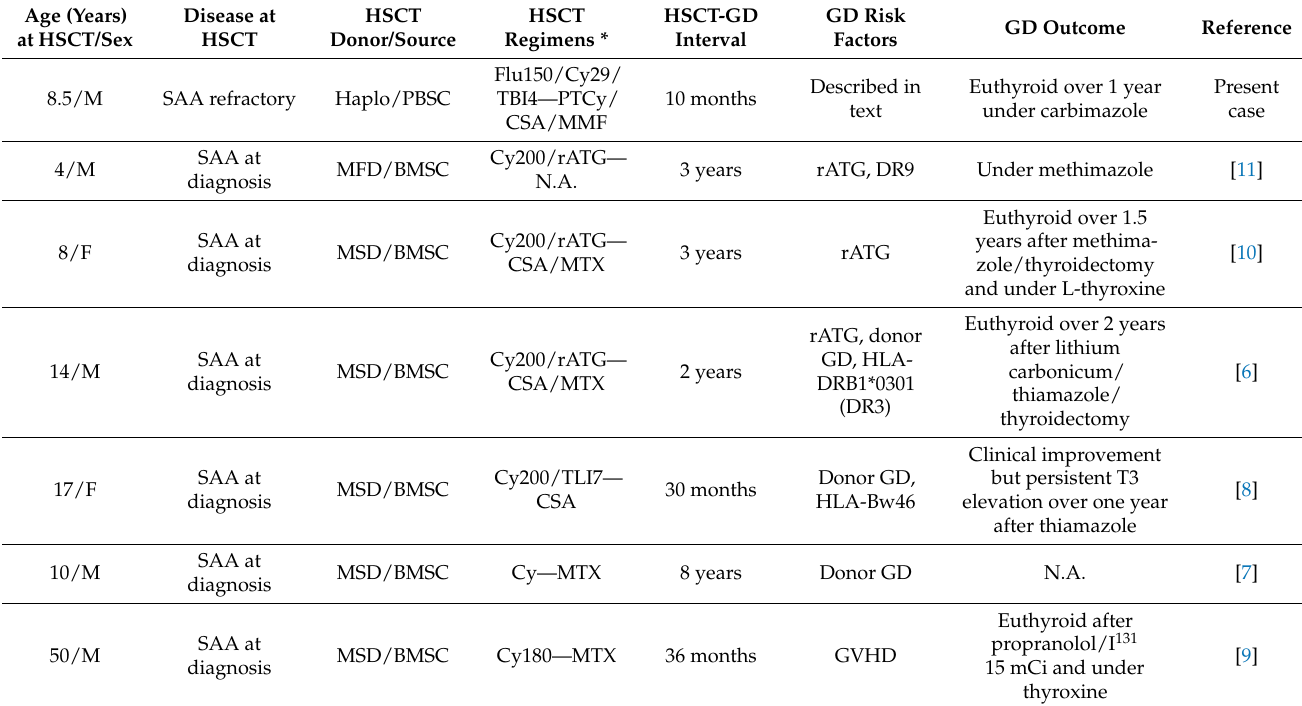
Table 2. Characteristics of patients who have developed Graves’ disease following allogeneic HSCT for severe aplastic